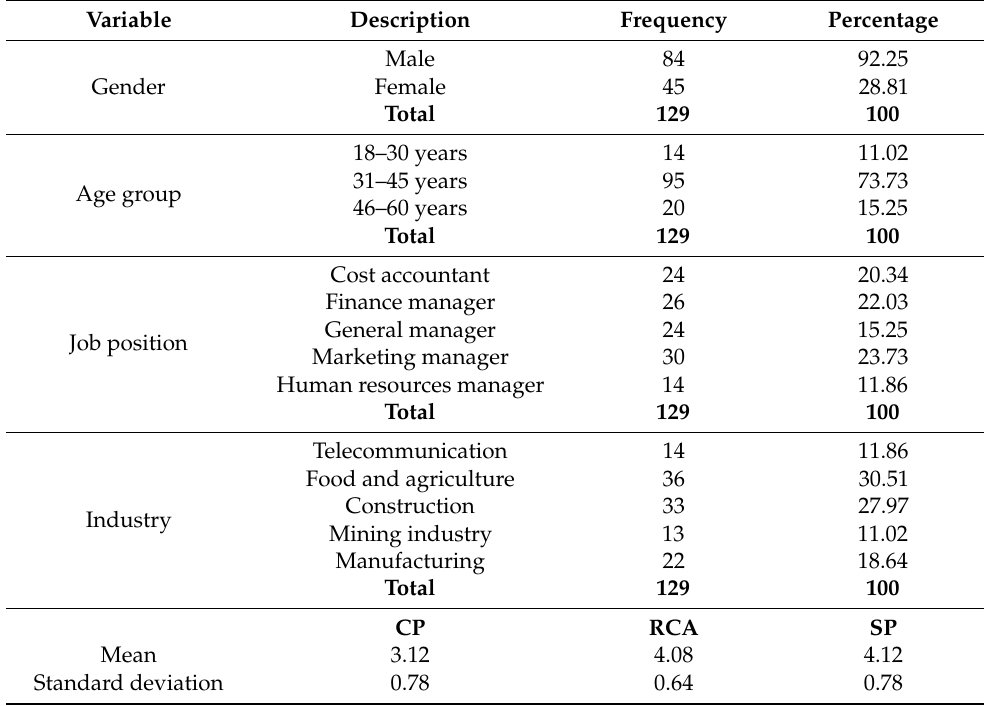
Table 2. Characteristics of Respondents in the